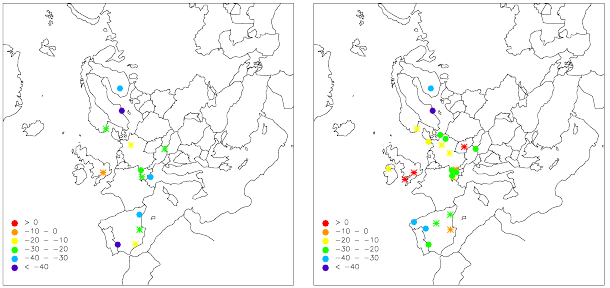
Fig. 7. Geographical distribution of the relative change in per cent in PM 2 . 5 (left) and PM 10 (right) in Europe over the 10yr 2000– 2009. Unit: percent. Sites with no significant trends are shown with a cross, and negative numbers indicate a decrease.